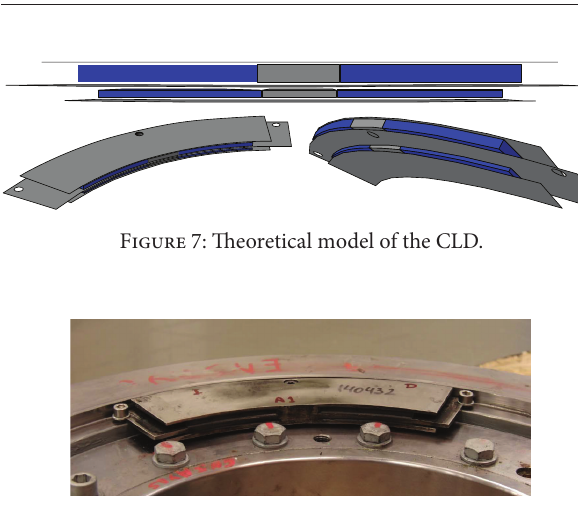
Figure 8: Real damper attached to the tram